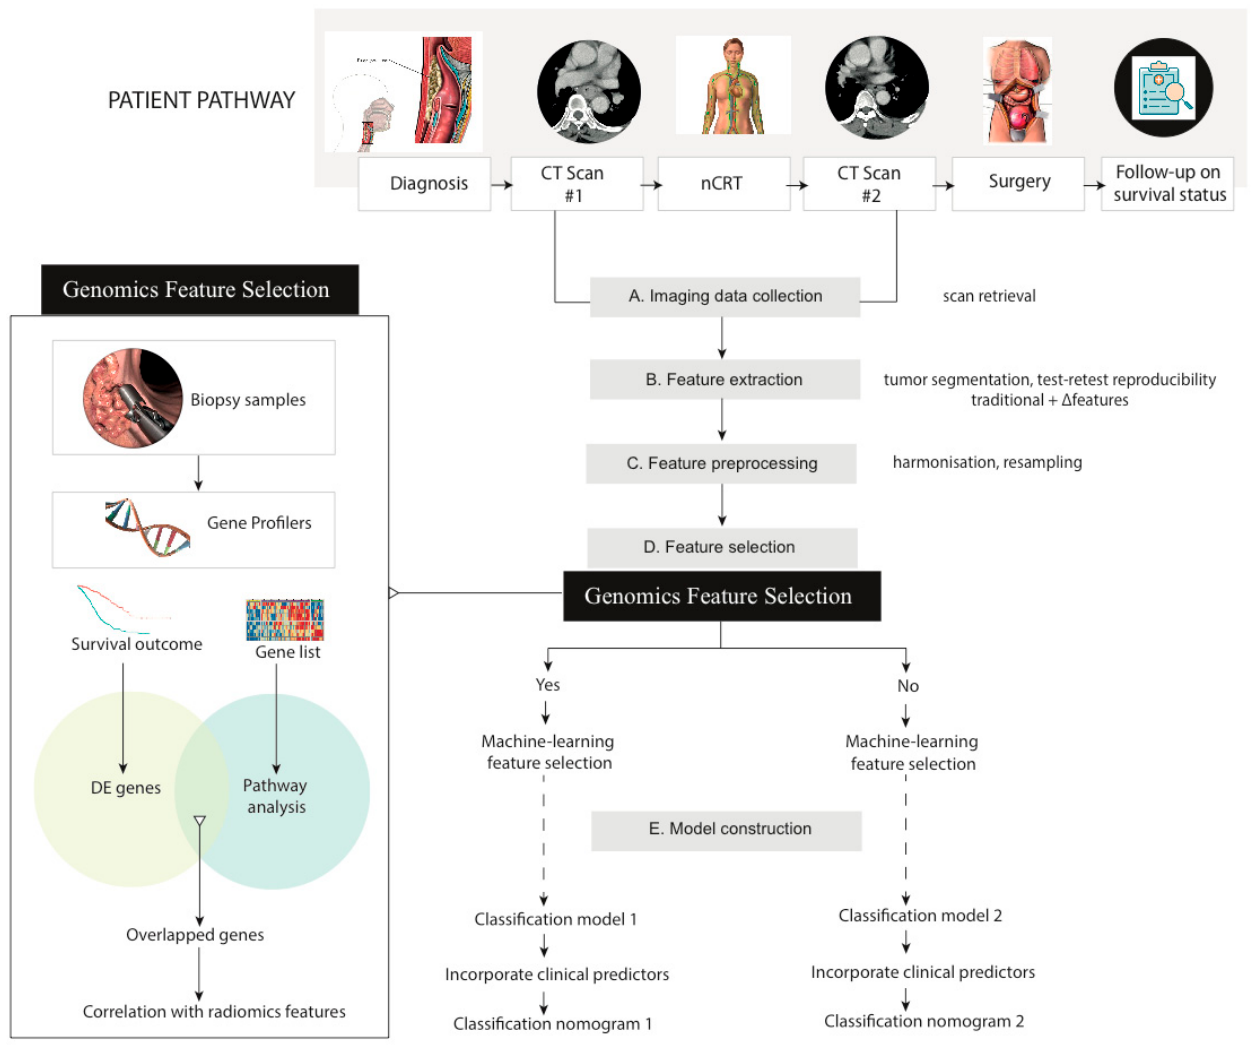
Figure 1. Study workflow. nCRT: neoadjuvant chemoradiotherapy; DE genes: differentially expressed genes.